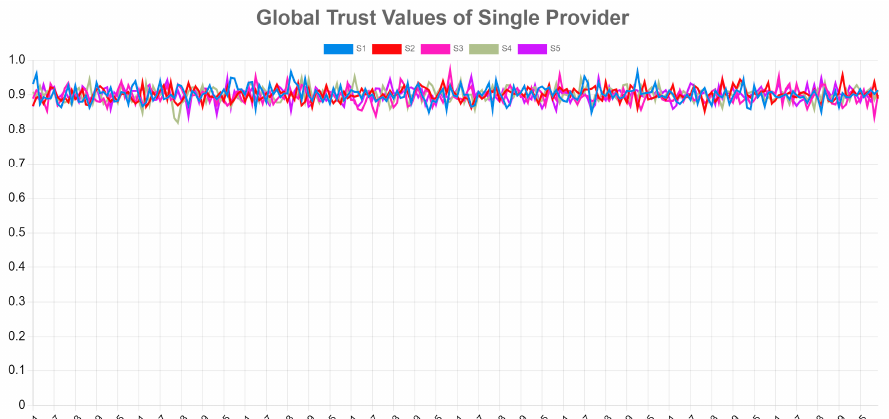
Figure 14. Global Trust Values (Tglobal) for 5 different services provided by SP3.